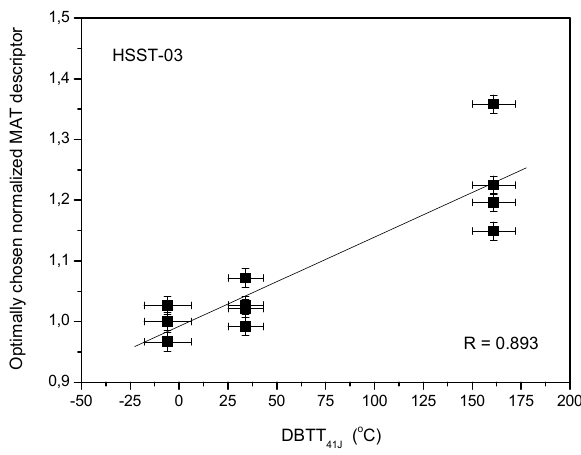
Figure 5. Optimally chosen MAT descriptor of reference and of irradiated HSST-03 type reactor steel base material as a function of transition temperature, DBTT.